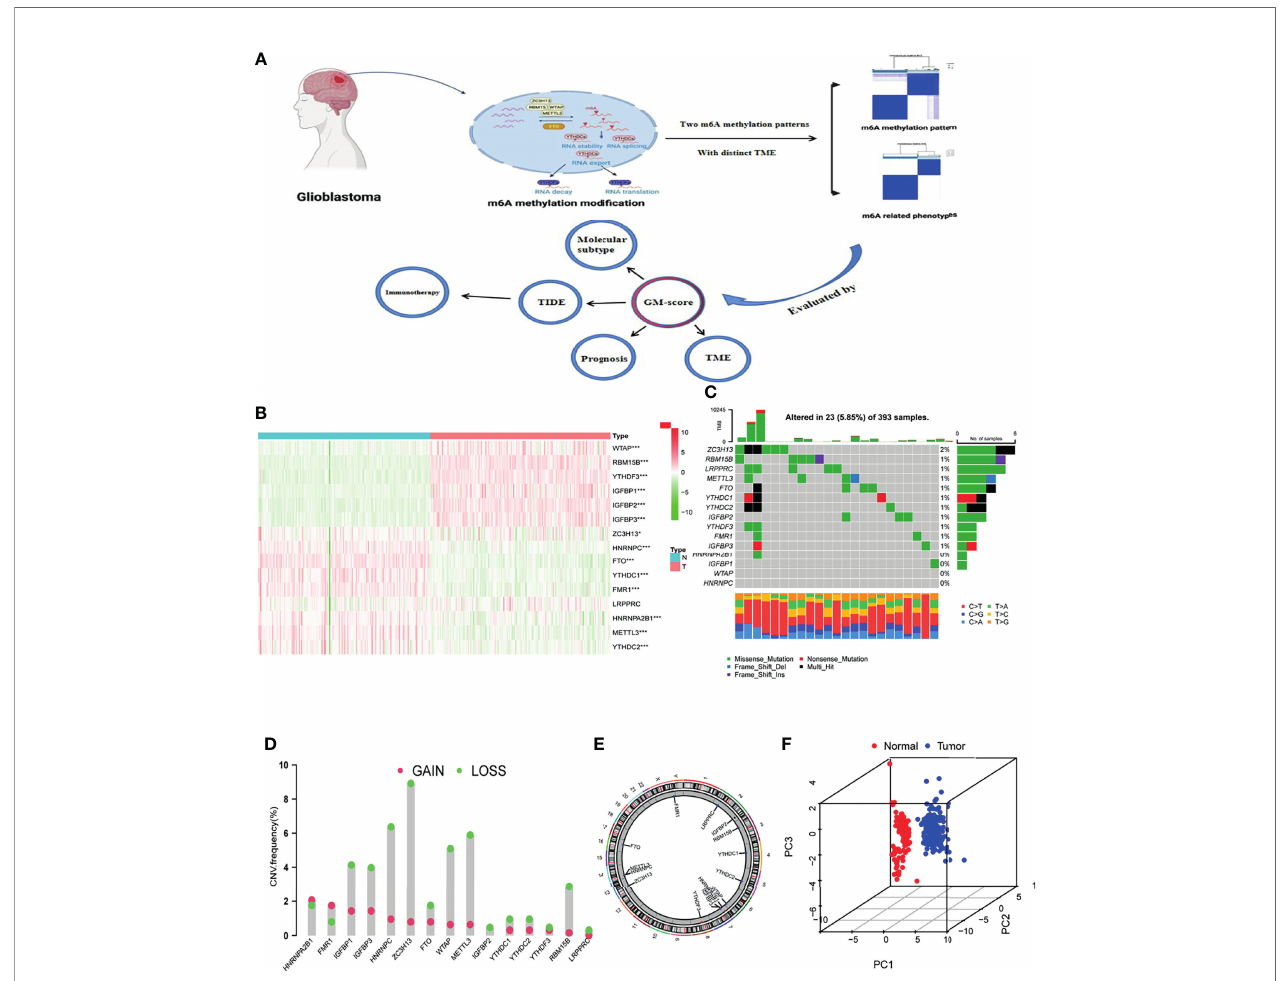
FIGURE 1 | Landscape of m6A methylation regulators in GBM. (A) Graphical summary of this study. The graphical summary was created with BioRender. (B) Heatmap of differential expression of m6A methylation regulators (Normal= 160, Tumor = 169; Normal sample from GTEx dataset, Tumor sample from TCGA- GBM dataset). (C) Mutation frequency of 15 m6A methylation regulators. (D) CNV variation frequencies of m6A methylation regulators in the TCGA-GBM cohort. Column height represents change frequency. Green indicates loss. Red indicates gain. (E) Chromosomal locations of altered CNV in the m6A regulators in